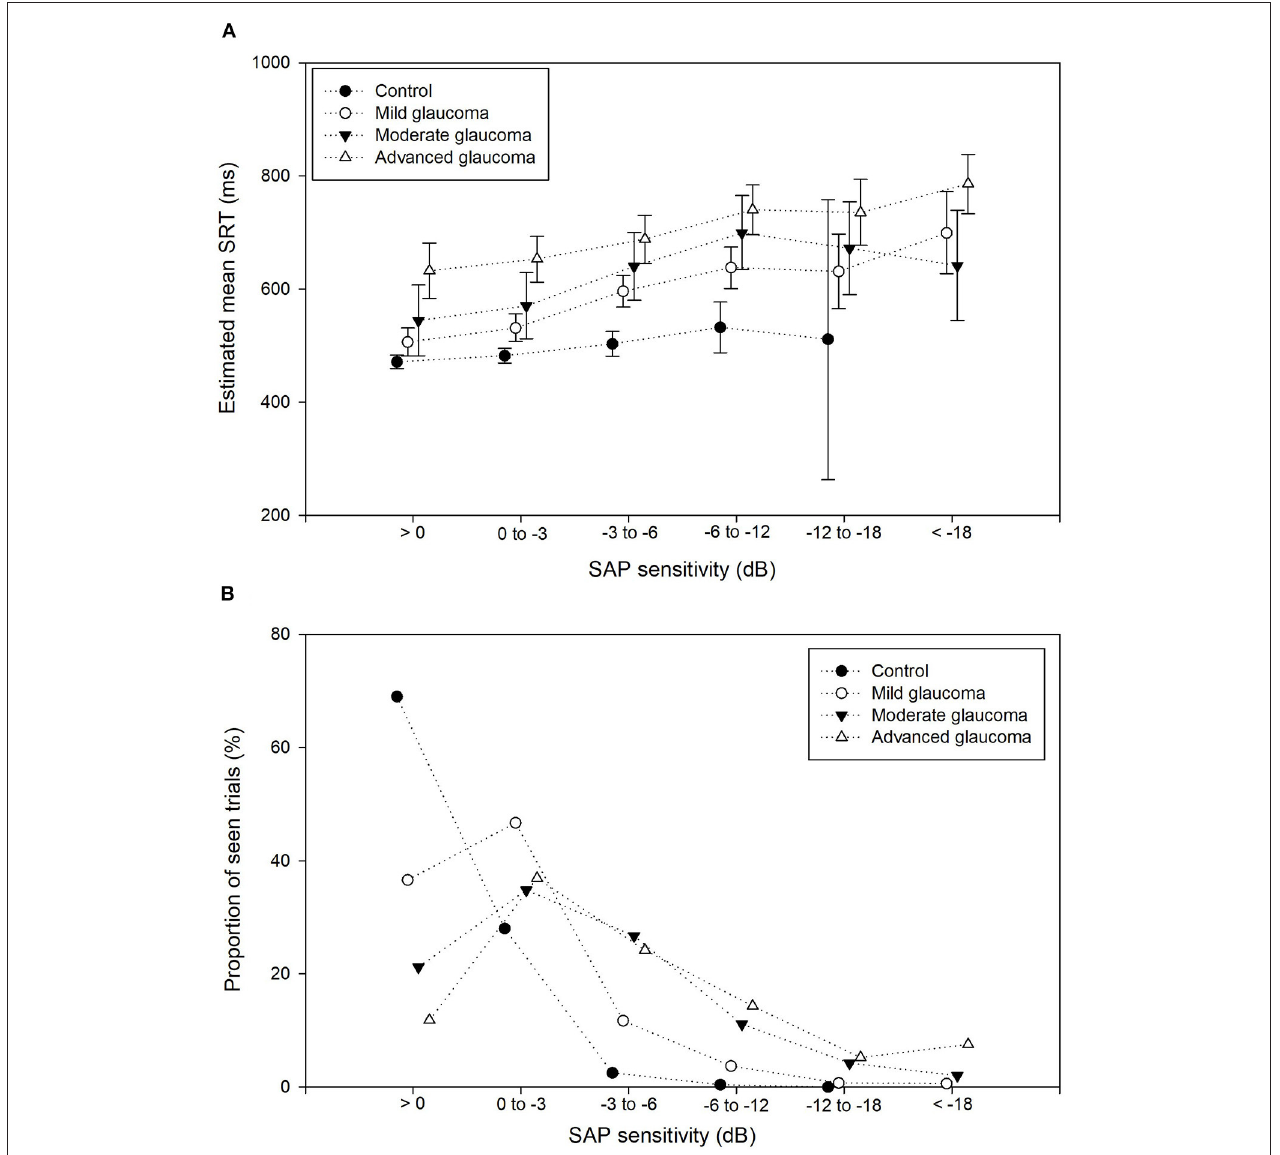
FIGURE 4 | Proportion seen trials and mean SRT per sensitivity bin. (A) Proportion of seen trials (%) for each of the 6 SAP sensitivity bins , stratified by the control group and glaucoma severity group. The proportion of seen stimuli decreased drastically with increasing SAP sensitivity loss. (B) Estimated mean SRTs and their corresponding 95% confidence intervals for the 6 SAP sensitivity bins , stratified by the control group and glaucoma severity group (dotted lines) show the increase of SRT with decreased retinal